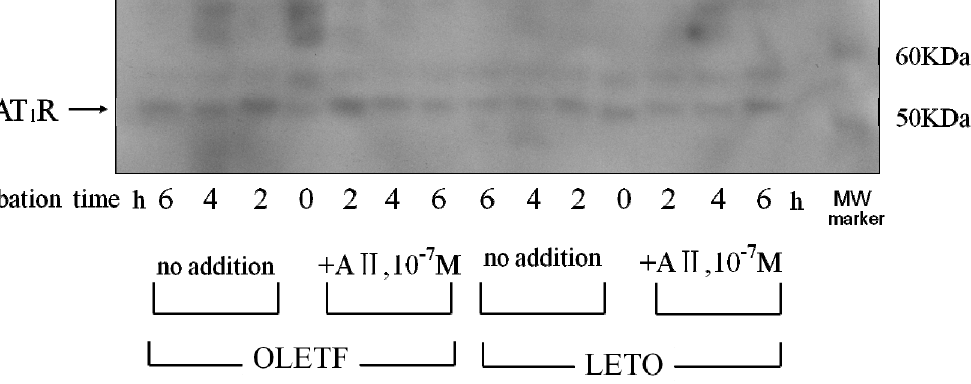
Figure 6. Effect of angiotensin II on AT1R protein expression. Rat AoSMC were incubated with “(+)” or without “( − )” 10 − 7 M angiotensin II for 2, 4 and 6 h. The pelleted cells were soon solubilized and subjected to SDS-PAGE using a linear gradient of 10%–20% acrylamide gel. All proteins were electrophoretically transferred to nitrocellulose membranes and analyzed using standard immunoblotting procedures. Molecular weight (MW) markers were run in the right lane.